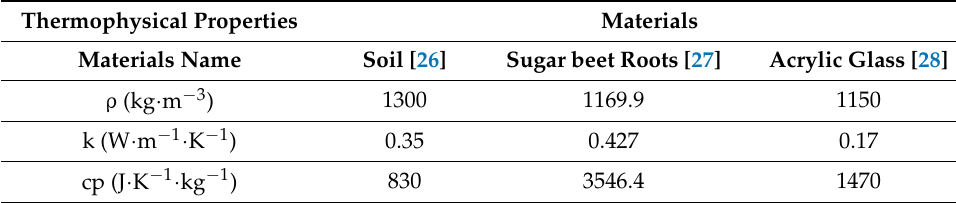
Table 1. Constant thermophysical properties of materials.